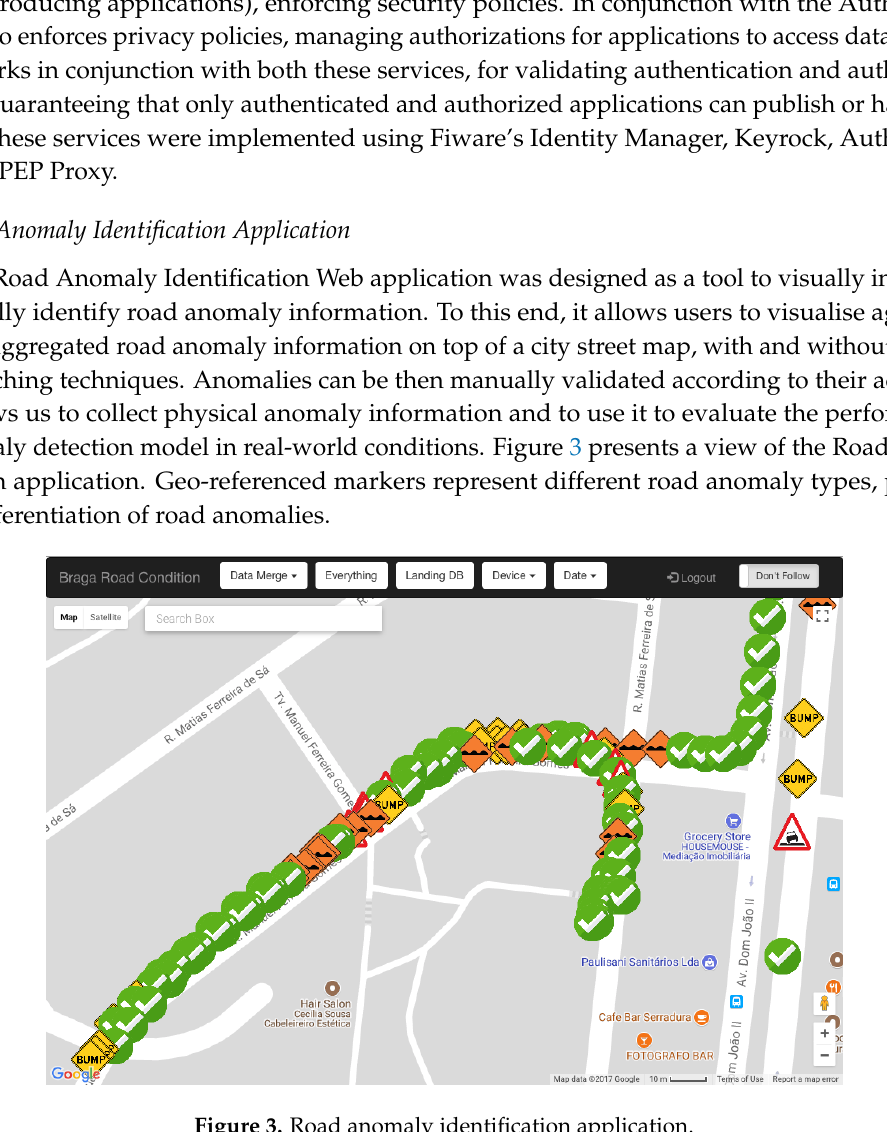
Figure 3. Road anomaly identification